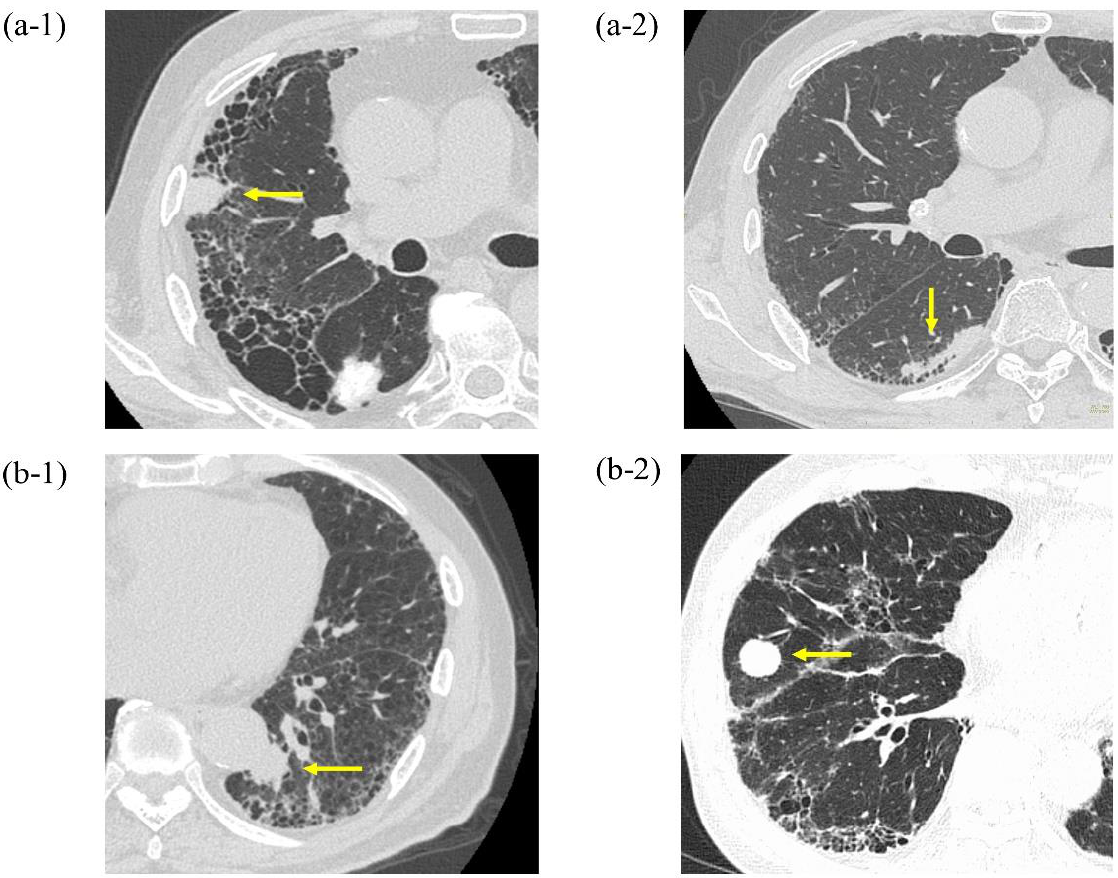
Figure 1. Chest computed tomography showing peripheral pulmonary lesions within or near fibrotic lesions ( a-1 , a-2 ) and those distant from fibrotic lesions ( b-1 , b-2 ).